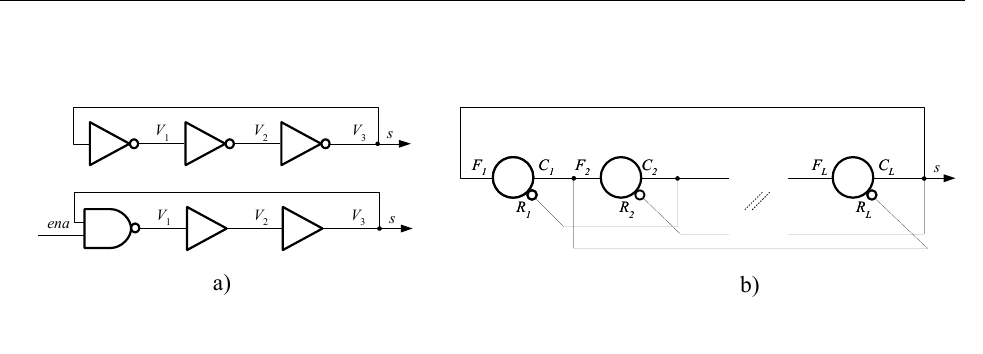
Figure 1: Generation of the jittery clock signal s in free running oscillators: ring oscillators (a) and self-timed rings (b)